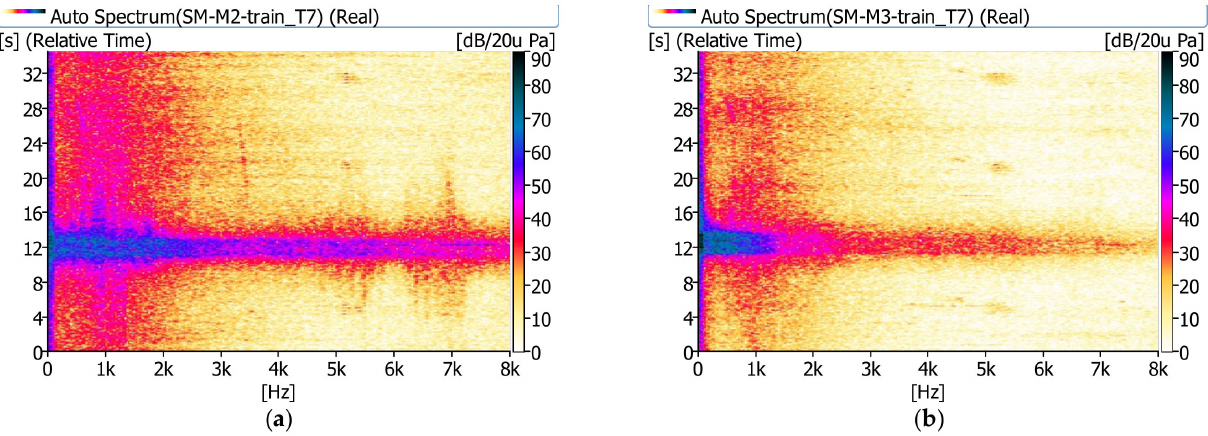
Figure 10. Spectrograms recorded during the passage of a railbus (T7): ( a ) next to the bridge (m.p. M2), ( b ) under the bridge (m.p.